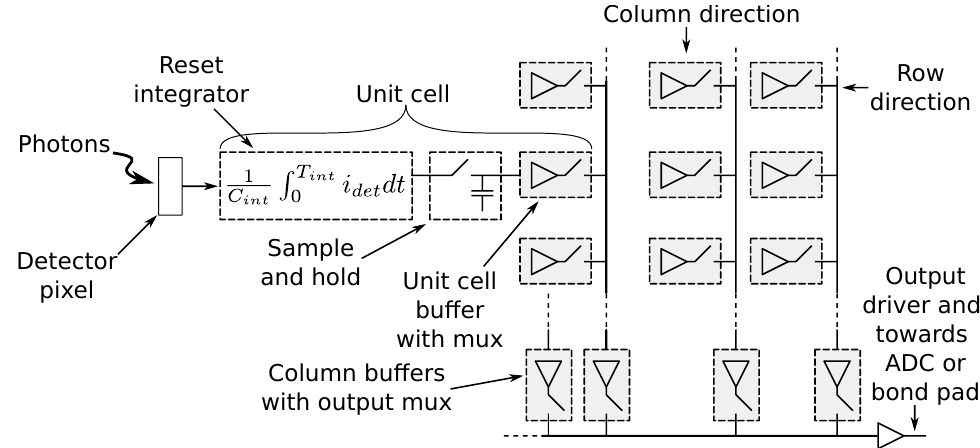
Figure 8. The basic signal path elements within ROIC (integrator, multiplexer, output driver) [6]. Notably, there is a variety of choices concerning ROIC design: internal or external 236 ADC(s), signal retrieval based on integrator or voltage sampler, signal multiplexing (from 237 unit cells) using voltage or charge, data sampling using snapshot (global) or rolling inte- 238